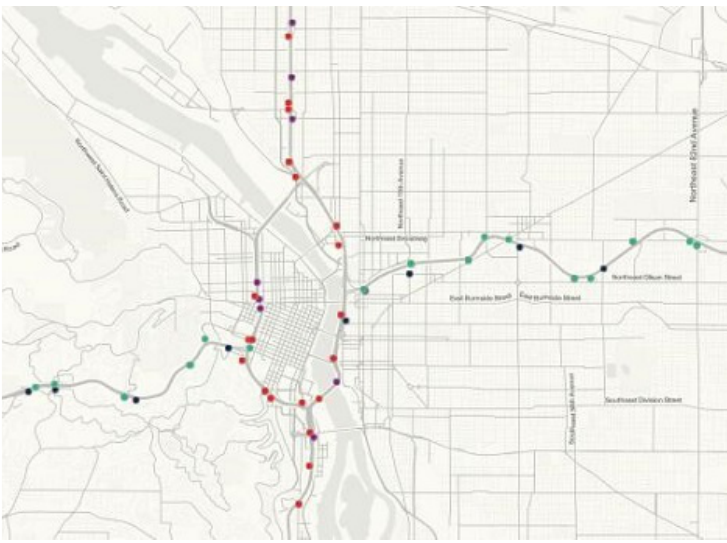
Figure 5. The selected sub-area road network of Portland, OR, USA.